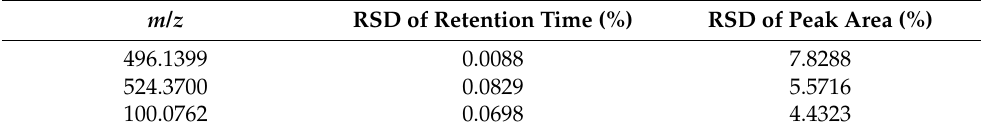
Table 1. The relative standard deviation (RSD%) of retention time and peak area in QC